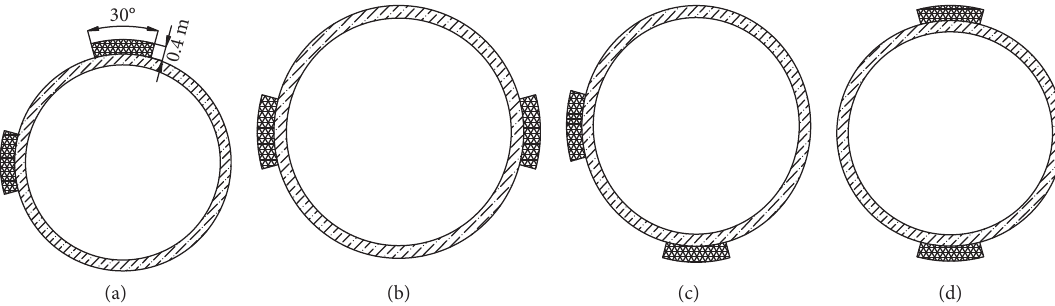
Figure 19: Combined working condition of double voids. (a) Vault and arch waist cavity. (b) Double-side arch waist cavity. (c) Arch waist and arch bottom cavity. (d) Arch top and arch bottom cavity.